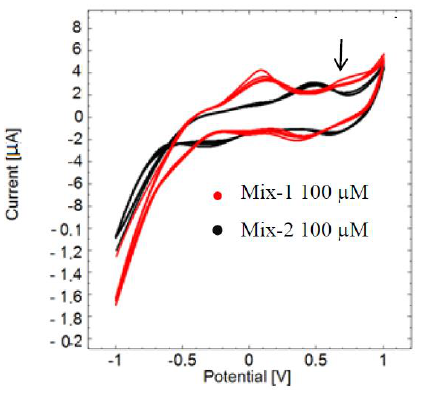
Figure 3. Cyclic voltammograms of mixture of compounds containing pyocyanin (mix-1, red curve) and mixture without pyocyanin (mix-2, black curve) measured versus the reference electrode. The red curve has a peak at 0.68 V confirming the presence of pyocyanin (arrow), while it is absent in the black curve of mix-2.